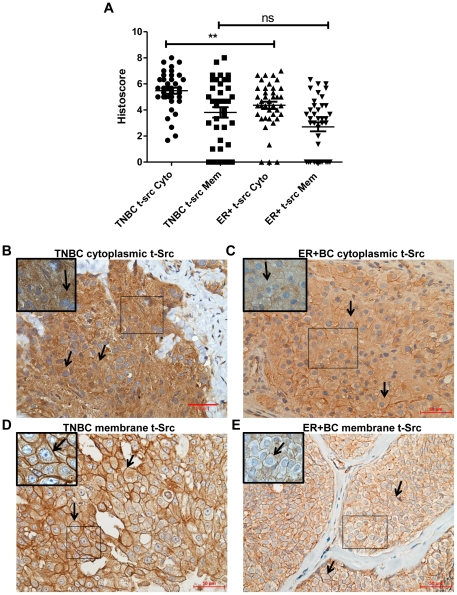
Evaluation of total Src expression in TNBC and ER+BC.A) Comparison of subcellular localization in the cytoplasm (Cyto) and membrane (Mem) of total Src (t-src) in TNBC and ER+BC. B) Representative TNBC case showing strong cytoplasmic (3+) t-Src staining (shown by arrows) (original magnification ×200). C) Representative ER+BC case showing moderate cytoplasmic (2+) t-Src staining (shown by arrows) (original magnification ×200). D) Representative TNBC case showing strong membrane (3+) t-Src staining (shown by arrows) (original magnification ×200). E) Representative ER+BC case showing moderate membrane (2+) t-Src staining (shown by arrows) (original magnification ×200). Statistical differences in the distribution of t-Src in TNBC and ER+BC was analyzed by the Mann-Whitney U test, **P<0.01, ns - not significant. Scale bar, 50 µm. Insets are magnified images from selected areas (small squares) to show the membrane and cytoplasmic Src staining clearly.